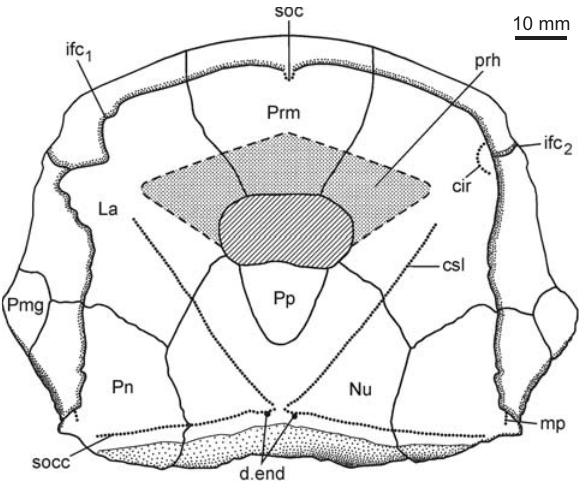
Fig. 8. Reconstruction of the head shield of antiarchan fish Bothriolepis leptocheira jeremejevi (Rohon, 1900), based on partial head shield (IG KSC 71/1-87), left (IG KSC 155/15), and right (IG KSC 155/65) lateral plates. Abbreviations: cir, semicircular pit-line groove; csl, central sensory line groove; d.end, opening of canal for endolymphatic duct; ifc 1 , principal section of infraorbital sensory line; ifc 2 , branch of infraorbital sensory line diverging on La; La, lateral plate; mp, middle pit-line groove; Nu, nuchal plate; Pmg, postmarginal plate; Pn, paranuchal plate; Pp, postpineal plate; Prm, premedian plate; prh, preorbital recess of head shield; soc, anterior section of the supraorbital sensory line; socc, supraoccipital cross-commis- sural pit-line